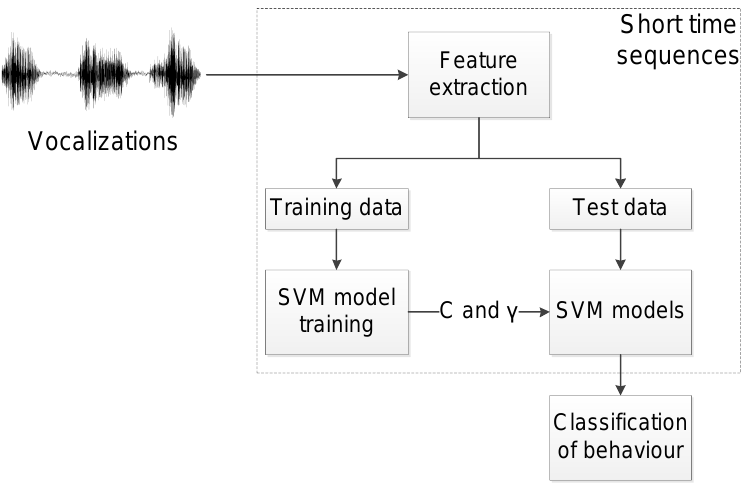
Figure 4. The flow of behaviour classification. The audio data is divided into short time sequences and feature extraction, modeling and classification is